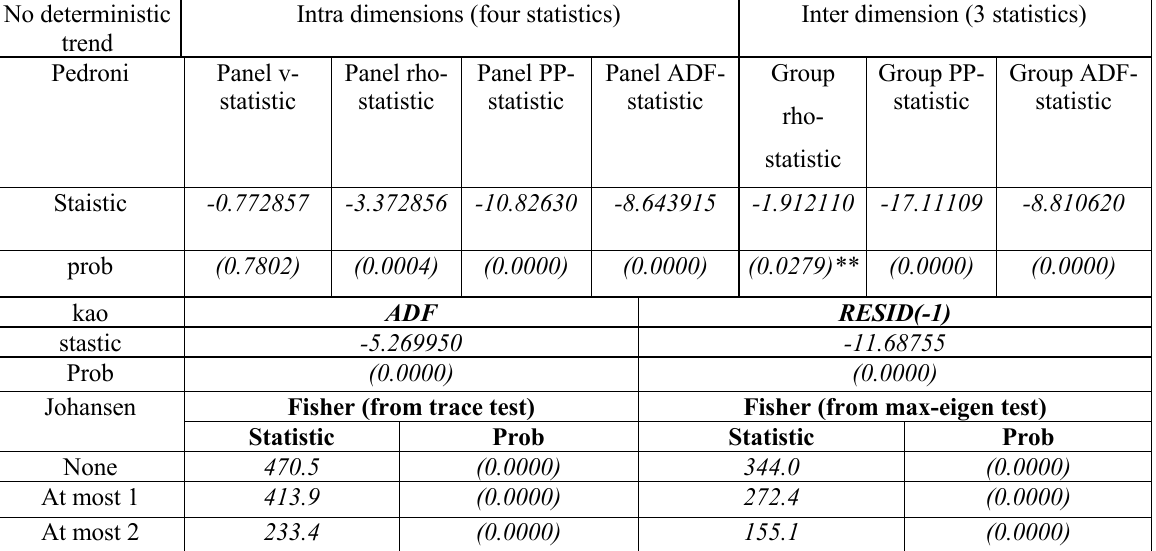
Table 3. Co-integration model